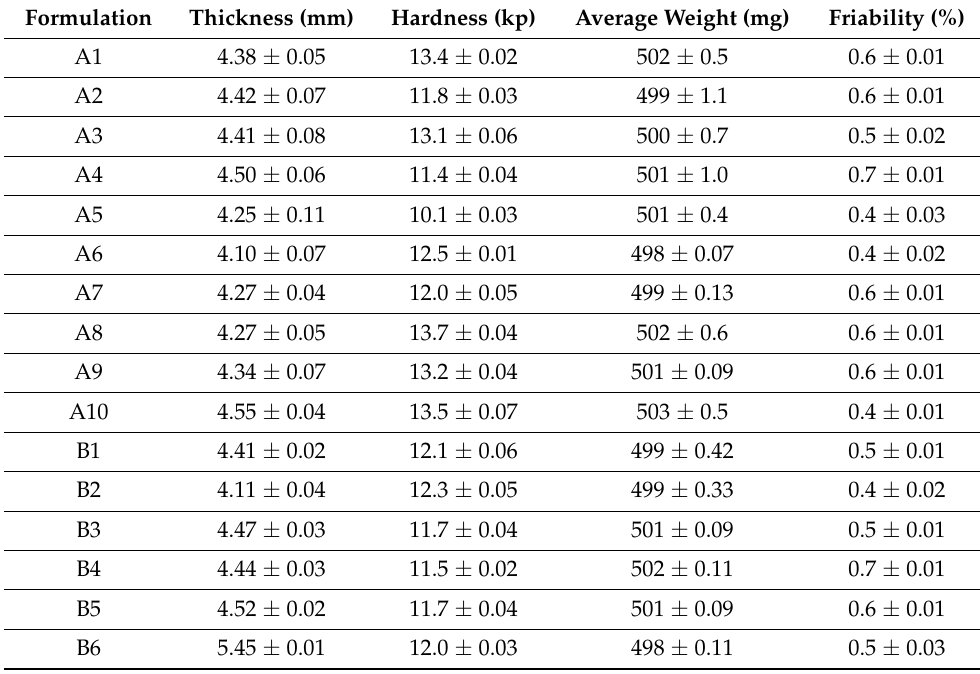
Table 4. Physical characteristics of the press-coated